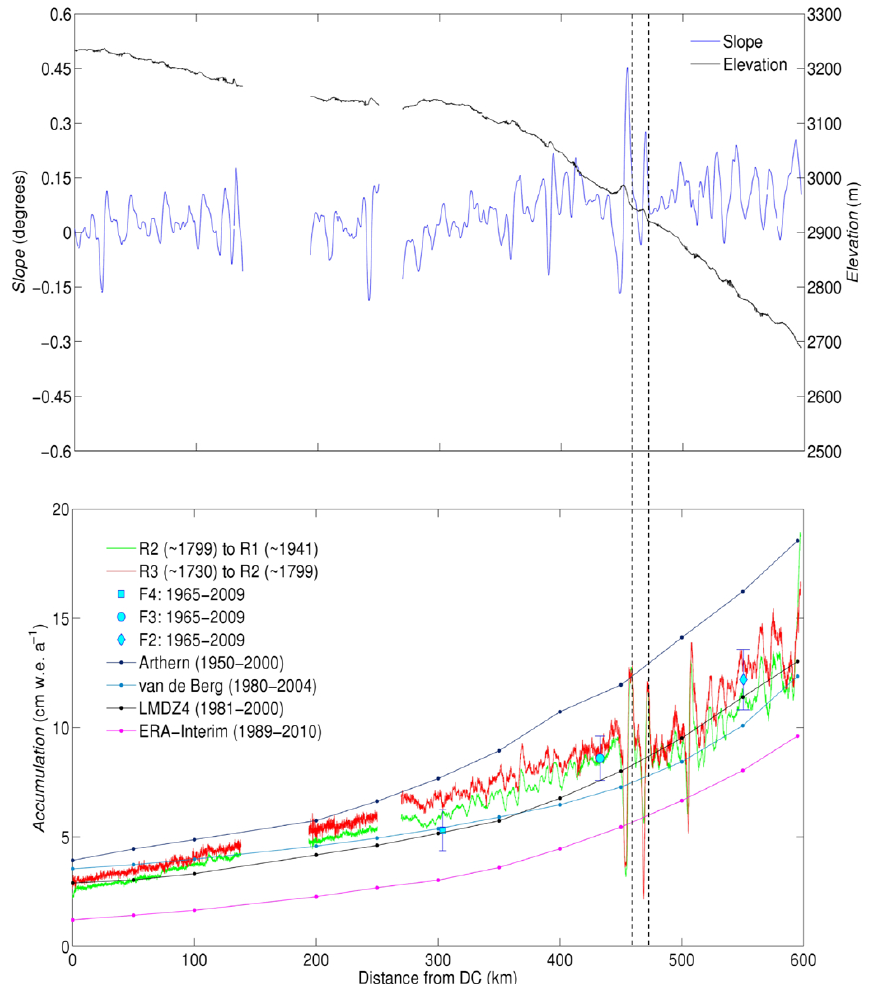
Fig. 9. Comparison of our accumulation results (radar and core measurements) and modelling results along the transect. Upper panel shows elevation and